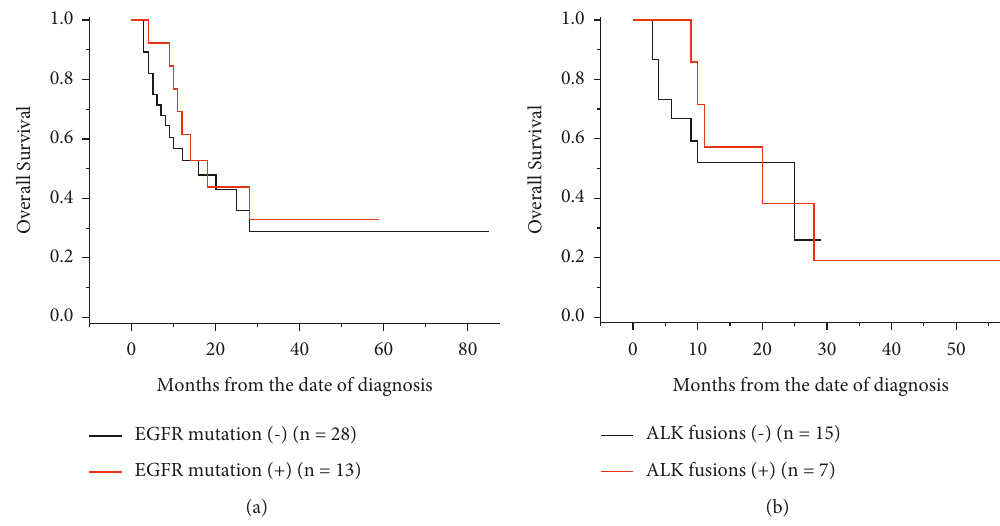
Figure 1: Correlation of EGFR mutation, ALK fusions, and patient survival by the Kaplan–Meier method. Table 4: Patient characteristics and ALK